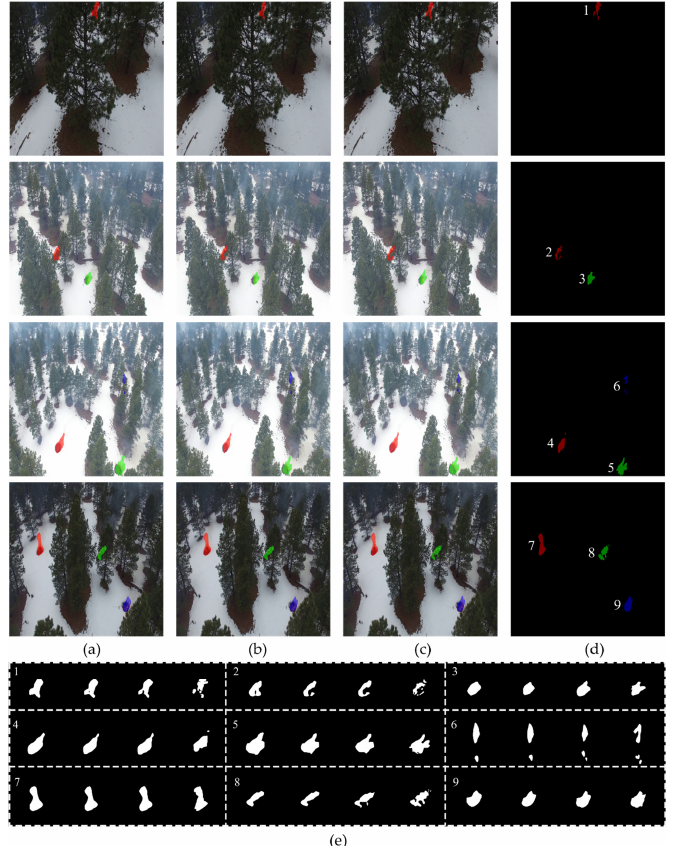
Figure 11. Predicted results of three different instance segmentation models: ( a ) mask R-CNN, ( b ) MS R-CNN, ( c ) our MaskSU R-CNN; ( d ) ground truth labels; and ( e ) segmentation details. Note that numbers 1 to 9 represent the order of fire points, and from left to right are the predicted results generated by Mask R-CNN, MS R-CNN, MaskSU R-CNN, and the corresponding ground truth la- bel.